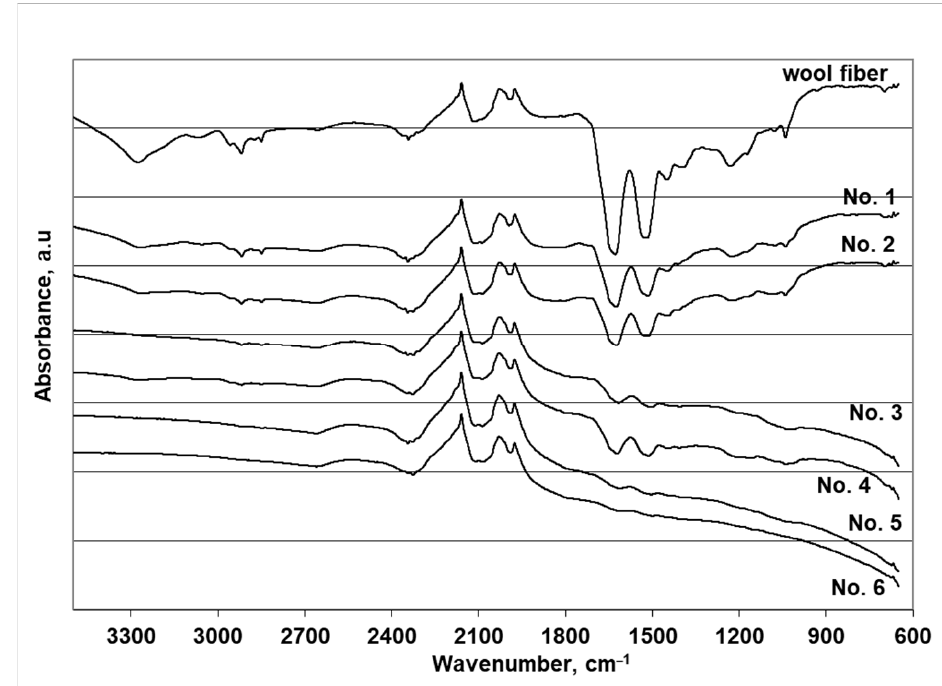
Figure 8. FTIR spectra of wool fiber and wool fibers with coatings of Cu x Se obtained with different numbers of cycles.